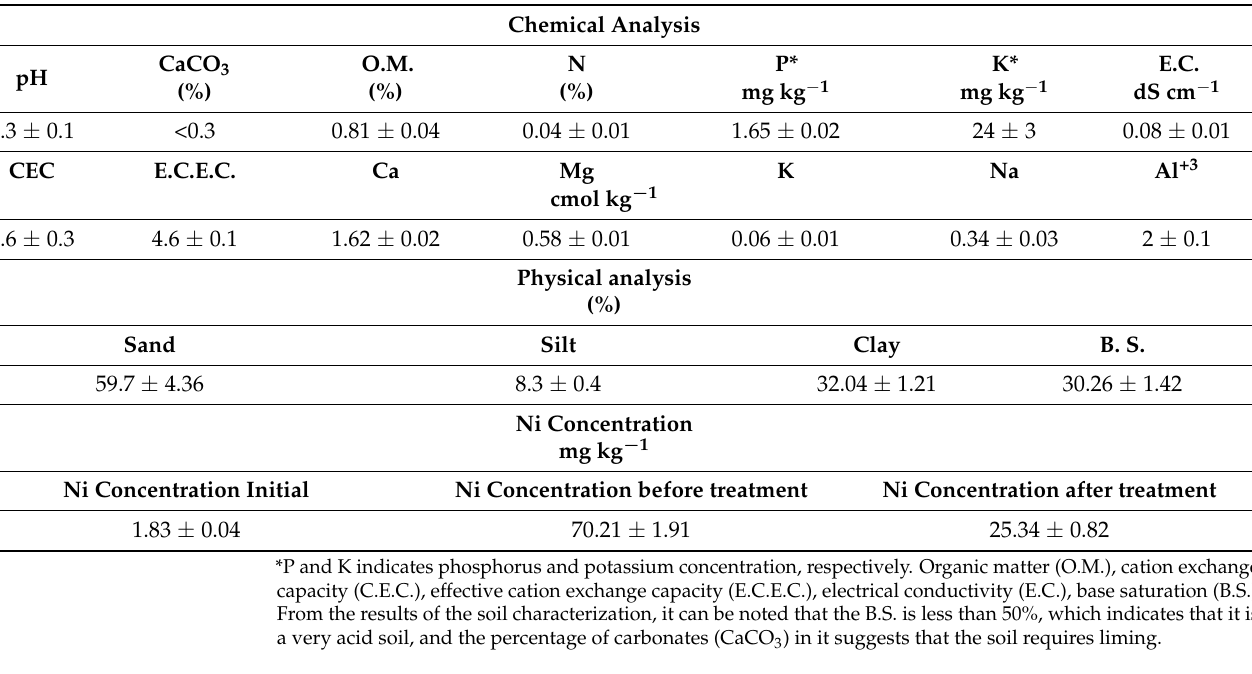
Table 1. Chemical and physical characterization of the substrate. (mean ± sd). Chemical